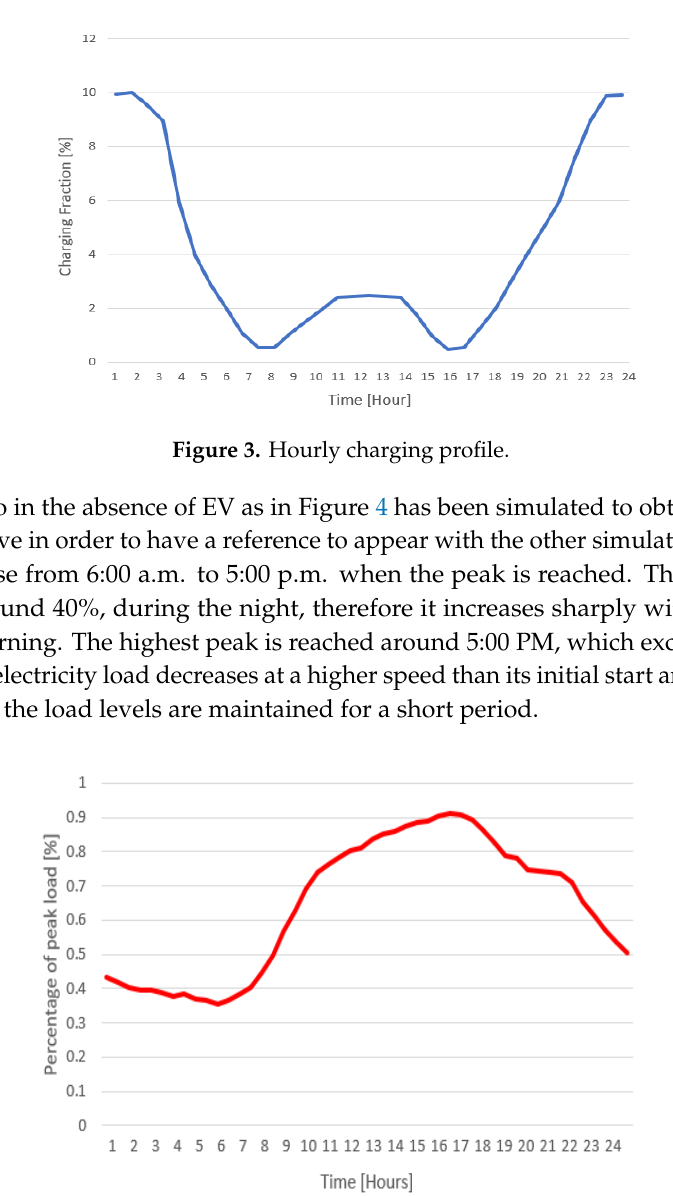
Figure 2. Simplified block diagram of the simulation procedure.